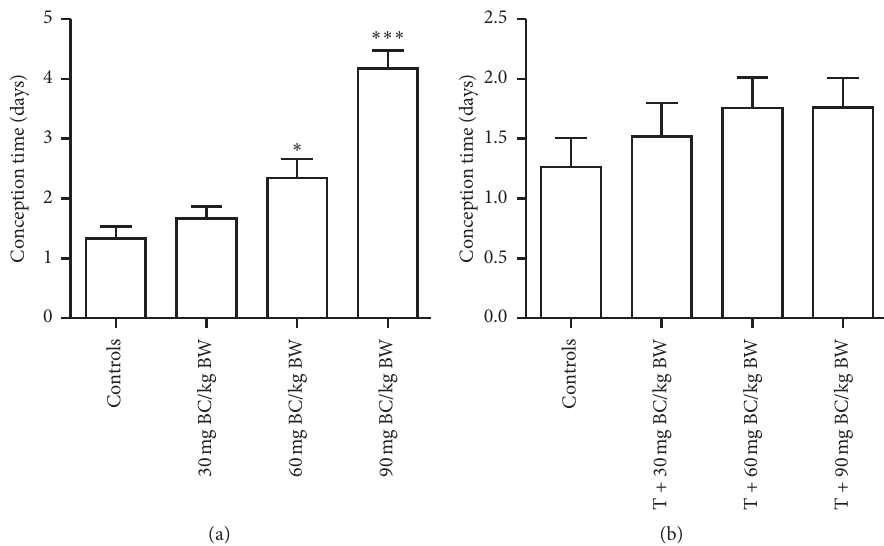
Figure 1: Conception time of females cohabitated with both baicalein (BC)-exposed (a) without ( n � 6) or (b) with ( n � 4) testosterone (T)- injected male mice; ∗ and ∗∗∗ represent significant difference from controls at P < 0 . 05 and < 0.001, respectively, where BW � body